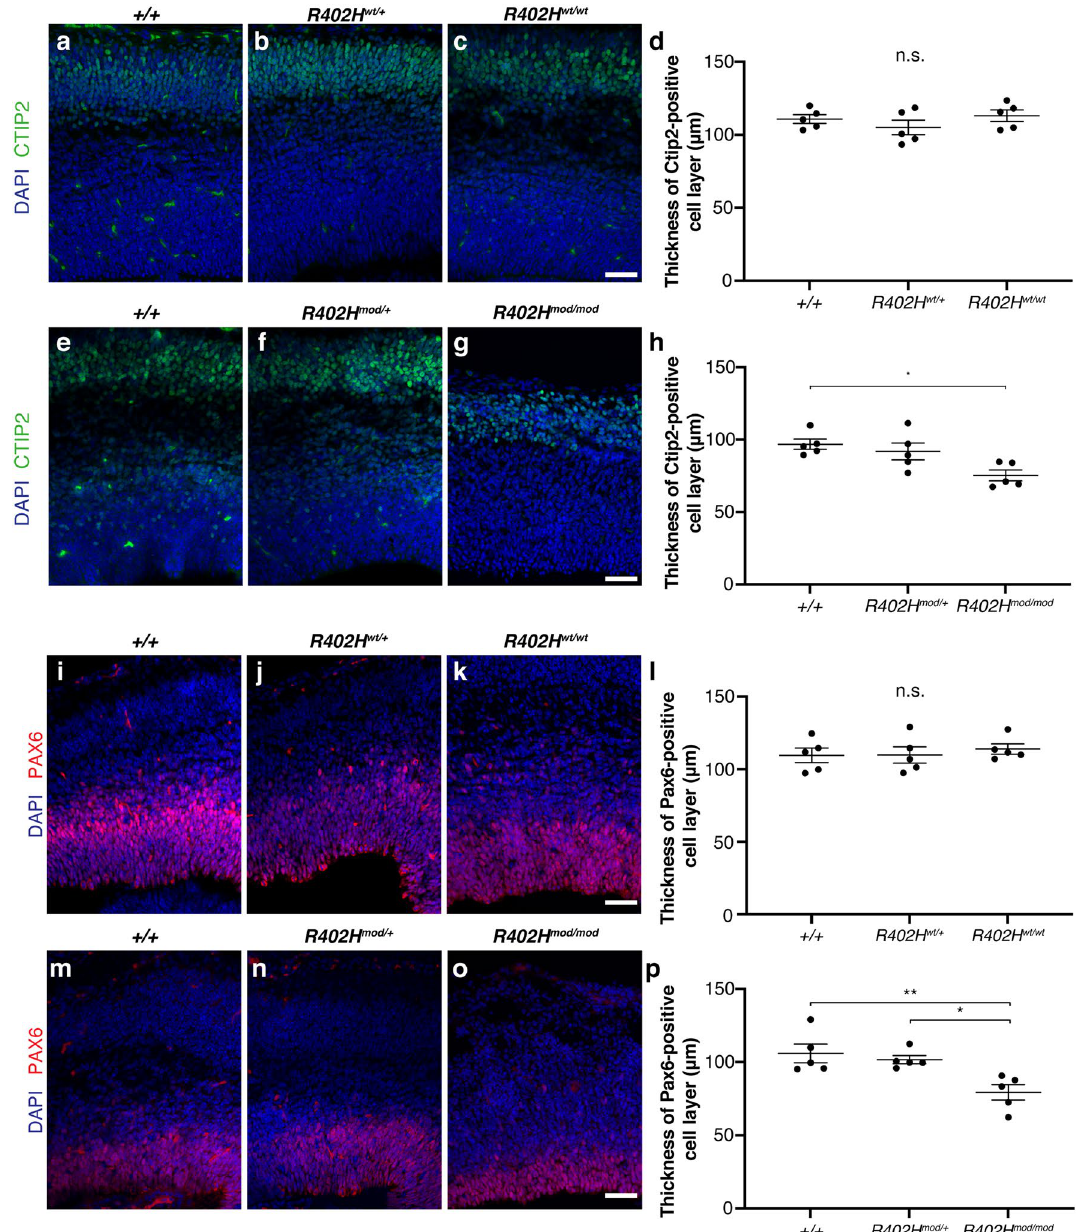
Figure 3. R402H mod /R402H mod embryos have a reduction in Ctip2 positive neurons and PAX6 positive progenitors. ( a–c ) Coronal sections of E16.5 embryos stained for the layer 5/6 neuronal marker Ctip2 from Tuba1a WT animals. ( a ) Wild-type (+/+); ( b ) heterozygous ( R402H wt / +), and ( c ) homozygous ( R402H wt / R402H wt ) animals are indistinguishable. ( d ) Quantification of Ctip2-positive neuronal layer reveals no significant different between homozygous animals and control littermates. ( e–g ) Representative coronal sections from Tuba1a modified embryos stained for Ctip2. ( e ) wild-type (+/+); ( f ) heterozygous ( R402H mod / +) and ( g ) homozygous ( R402H mod /R402H mod ) animals. ( h ) Quantification shows a significant reduction in Ctip2 layer thickness in homozygous R402H mod /R402H mod compared to wildtype littermates. Scale bars indicate 50 μm. ( i–k ) Representative coronal sections from E16.5 embryos stained for neural progenitor marker Pax6. (I) Wild-type (+ / +); ( j ) heterozygous ( R402H wt / +), and ( k ) homozygous ( R402H wt /R402H wt ) animals. ( l ) Quantification of ventricular zone thickness shows no significant different between homozygous animals and control littermates. ( m–o ) Coronal sections from Tuba1a modified embryos stained for Pax6. ( m ) wild-type (+/+); ( n ) heterozygous ( R402H mod / +) and ( o ) homozygous ( R402H mod /R402H mod ) animals. ( p ) Quantification shows a significant reduction in VZ thickness in homozygous R402H mod /R402H mod compared to wildtype littermates. One-way ANOVA with Tukey’s test for multiple comparisons. P * < 0.05, P ** < 0.01. Error bars show Mean ± SEM. Scale bars indicate 50